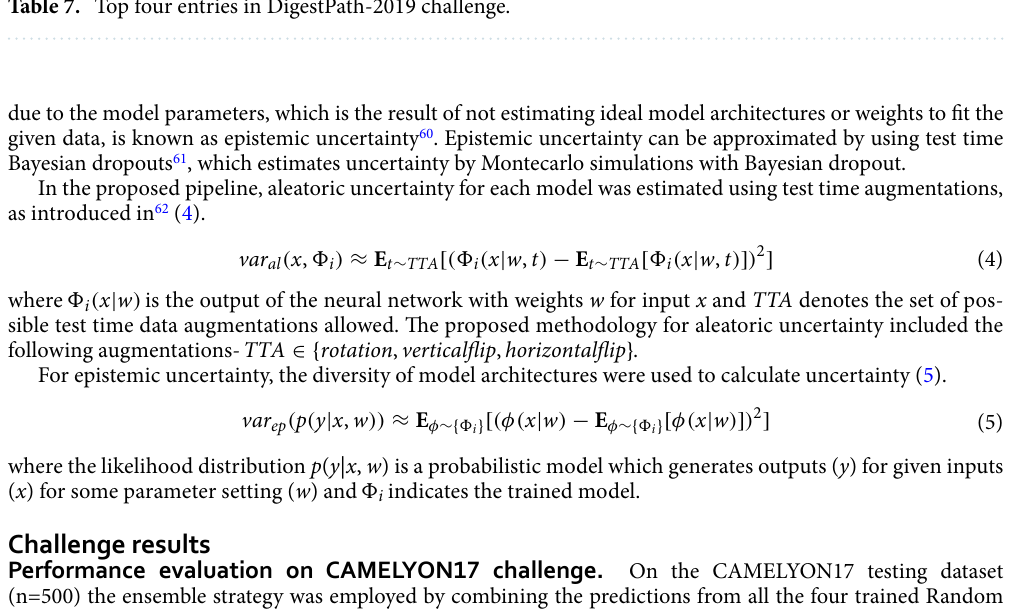
Table 7. Top four entries in DigestPath-2019